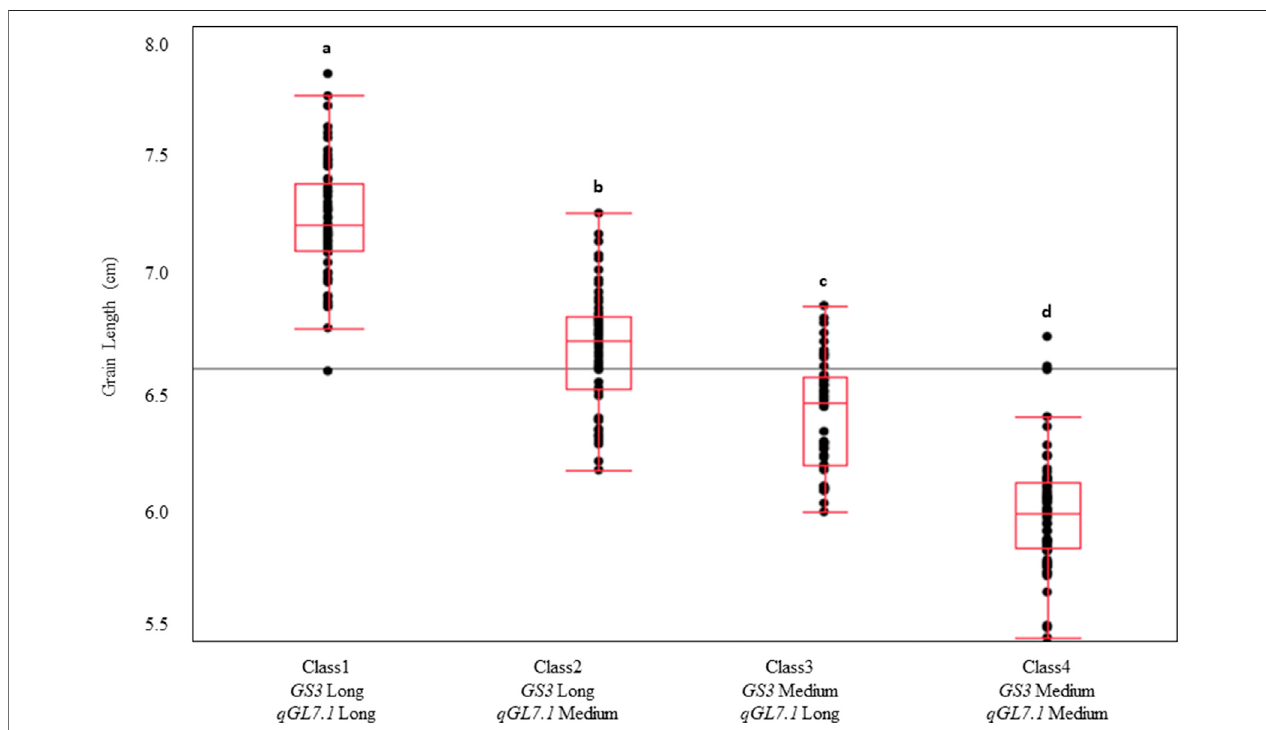
FIGURE 4 | Genotypic classes of Trenasse/Jupiter RILs based on the alleles at GS3 and qGL7.1 in the RIL population. Four genotypic classes were identi fi ed based on the allele state at GS3 and qGL7.1. Classes denoted by a different letter indicate signi fi cant differences between classes ( p < 0.001).